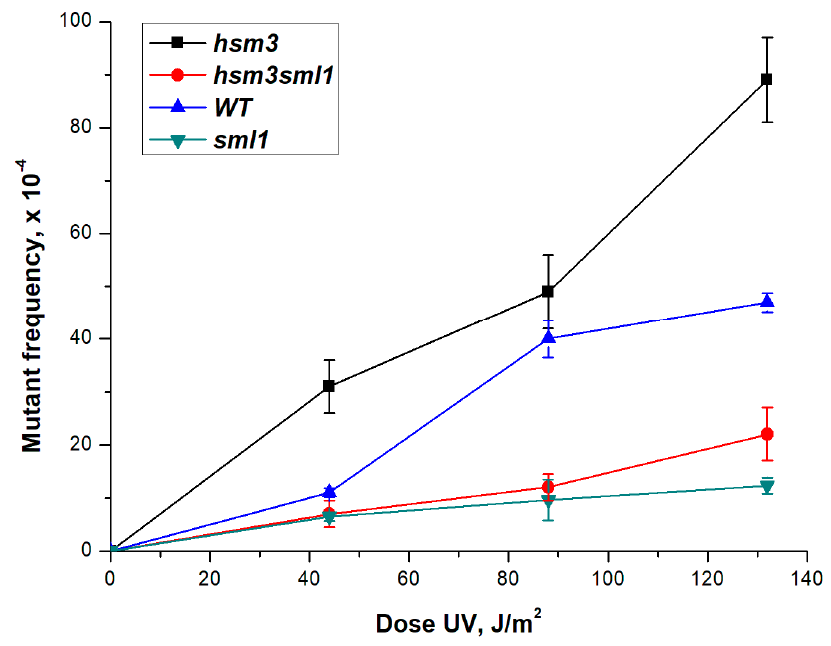
Figure 6. UV-induced mutagenesis in strain wild-type (LMG-3031) and mutant strains hsm3 Δ (5- LGM-3031), hsm3 Δ sml1 Δ (TAE-151), sml1 Δ (6- DVF-3031) at different UV doses. The mutation frequencies were determined, as a ratio of the number of white colonies to the number of all colonies grown in a cup with complete medium. The mean ± SEM values obtained from 4 independent experiments are plotted.